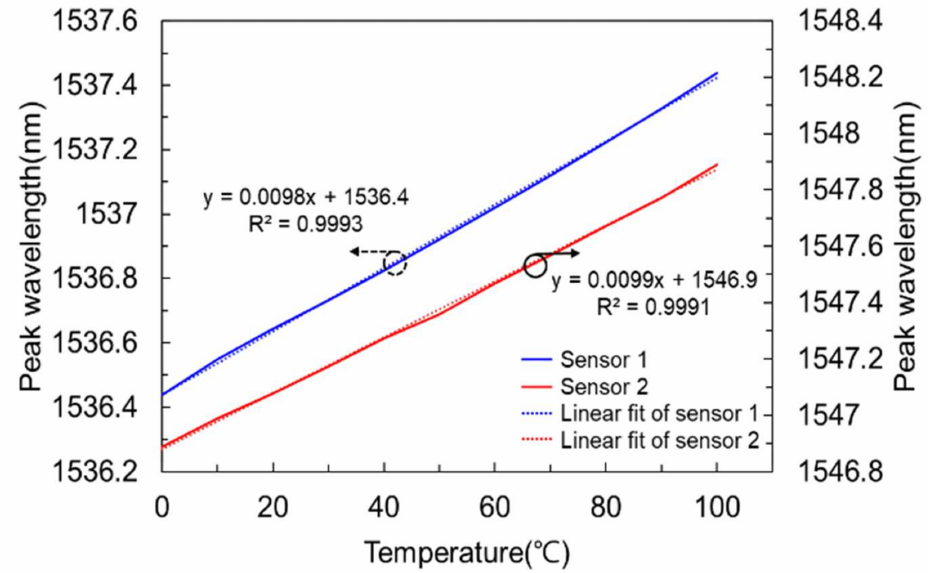
Figure 7. Output characteristics of packaged optical sensors 1 and 2 measured using an optical spectrum analyzer (AQ6319, YOKOGAWA).